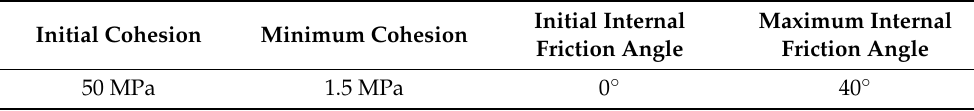
Table 4. Variation of the cohesion and friction.